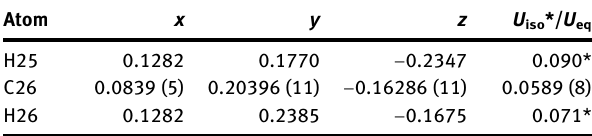
Using Olex2 [1], the structure was solved with the ShelXS [2] program using Direct Methods and re fi ned with the ShelXL [3] re fi nement package.